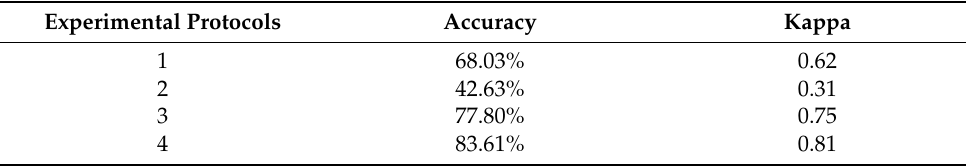
Table 4. Results of experimental protocols.